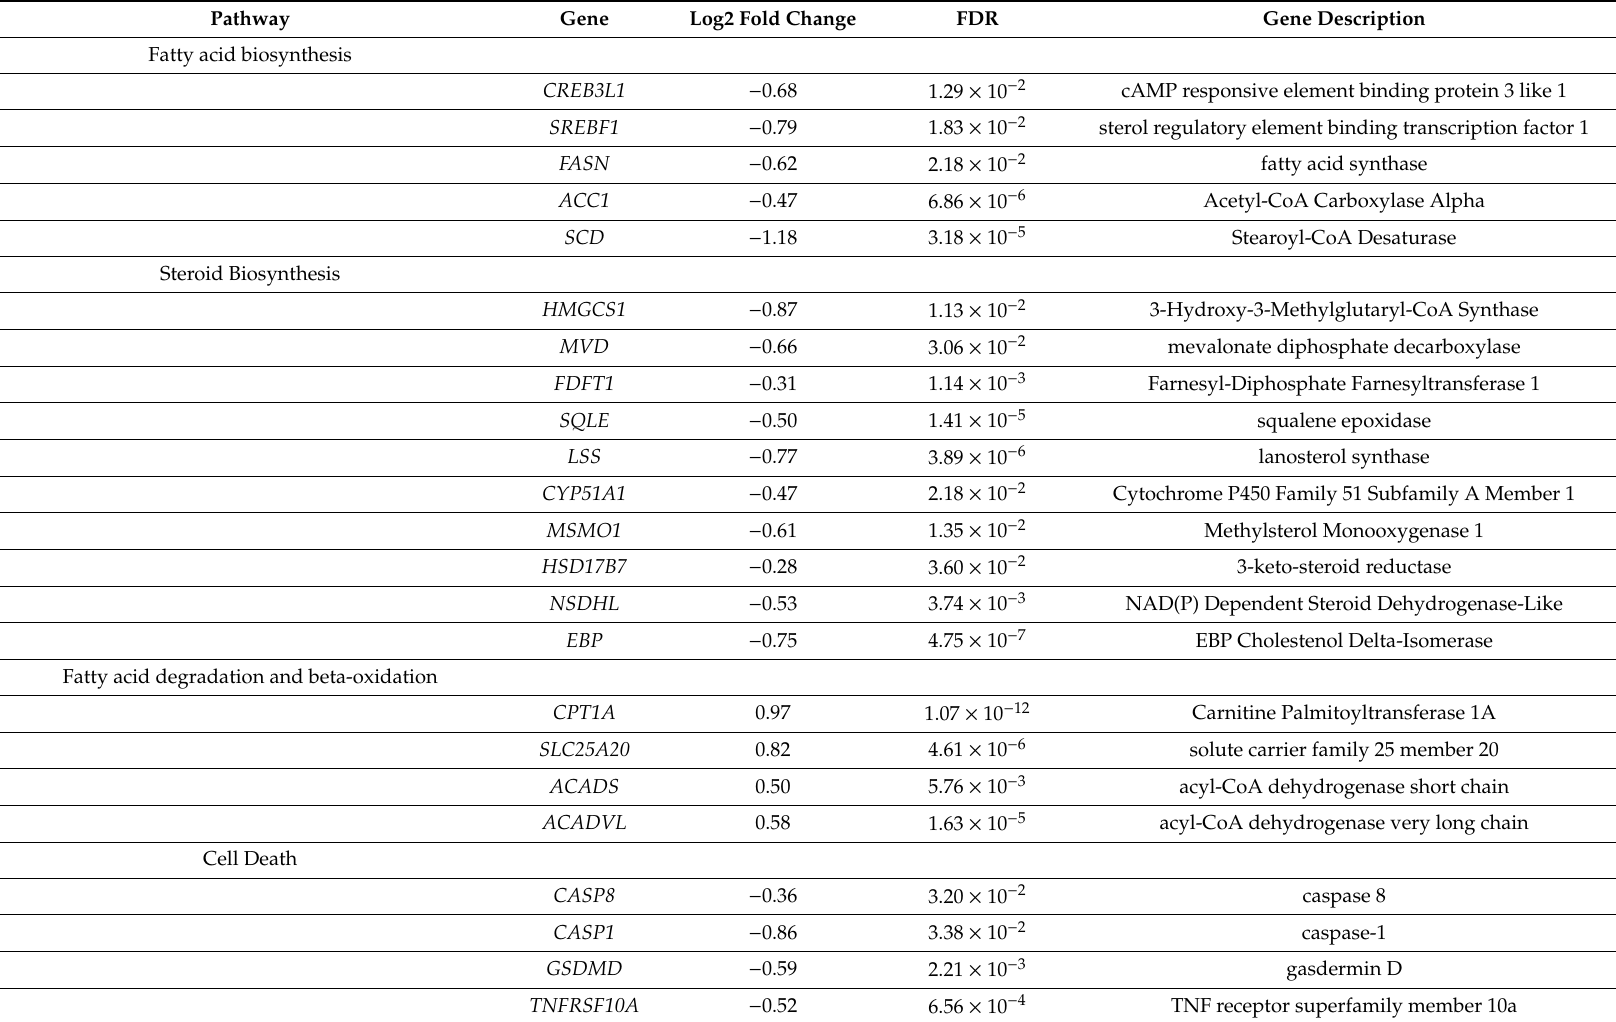
Table 2. Relevant pathways and associated genes modified by 10 µ M SA incubated for 24 h in mRPE